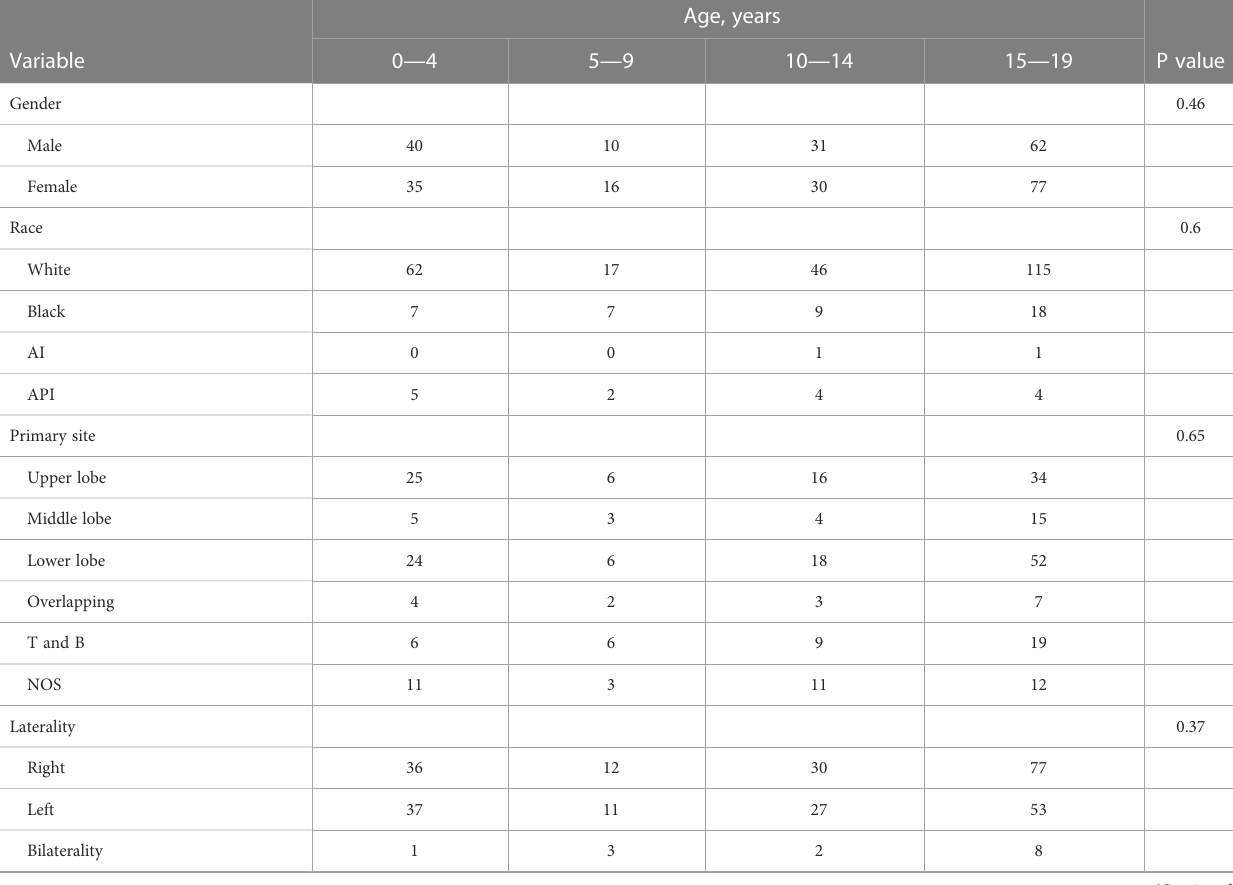
TABLE 2 Demographics and Clinical Characteristics by age